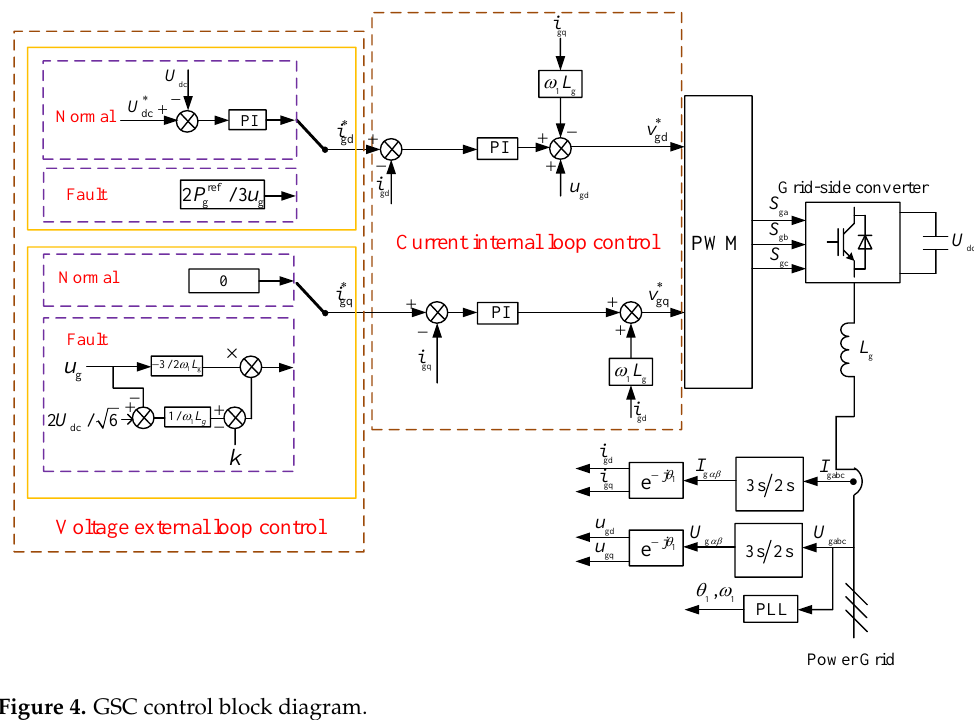
Figure 4. GSC control block diagram.